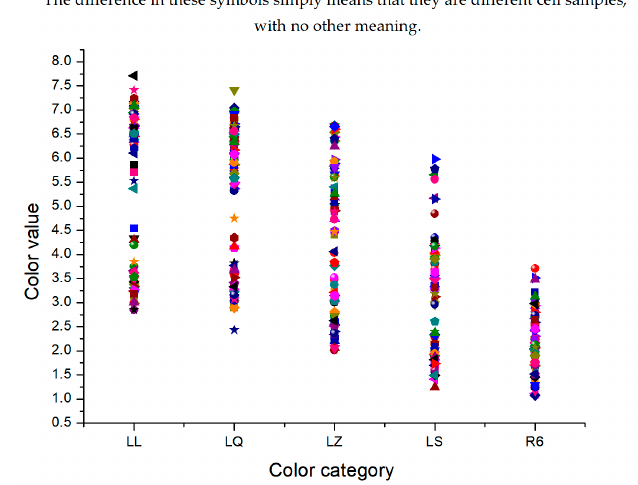
Figure 5. The standard deviation curve of five average values of color categories at different wavelengths.